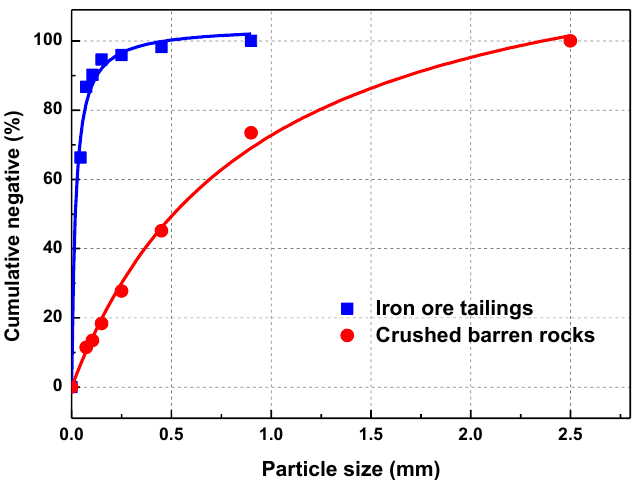
Figure 2. Particle-size distributions of iron ore tailings and crushed barren rocks.